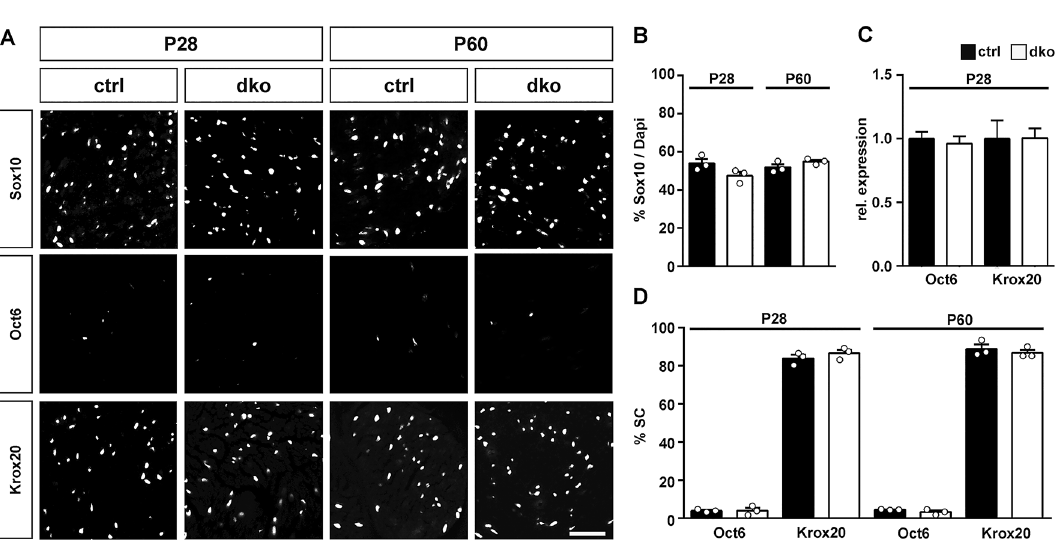
Figure 5. Expression of stage-specific transcription factors in sciatic nerves of adolescent and adult dko mice. ( A ) Representative stainings on sciatic nerve sections of control and dko mice at P28 and P60 with antibodies directed against Sox10, Oct6 and Krox20. Scale bar, 25 µm. ( B ) Quantification of the percentage of Schwann cells among all cells in the sciatic nerve of control (black bars) and dko (white bars) mice at P28 and P60 (n = 3). ( C ) Quantification of the amount of Oct6 and Krox20 transcripts by qRT-PCR in sciatic nerves of control (black bars) and dko (white bars) mice at P28 (n = 4). Transcript levels in controls were set to 1 for each gene, those for dko mice expressed relative to it (± SEM). ( D ) Quantification of the percentage of Schwann cells that express Oct6 and Krox20 in the sciatic nerve of control and dko mice at P28 and P60 (n = 3; mean values ± SEM). Numbers were not significantly different as determined by unpaired, two-tailed Student’s t-test. For p-, t- and df-values, see Supplementary Fig.